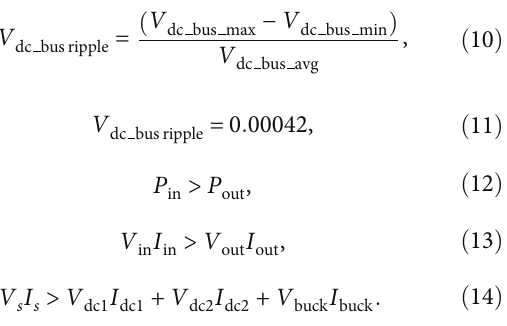
Figure 9: I , DC bus voltage V buck BDC in buck mode.